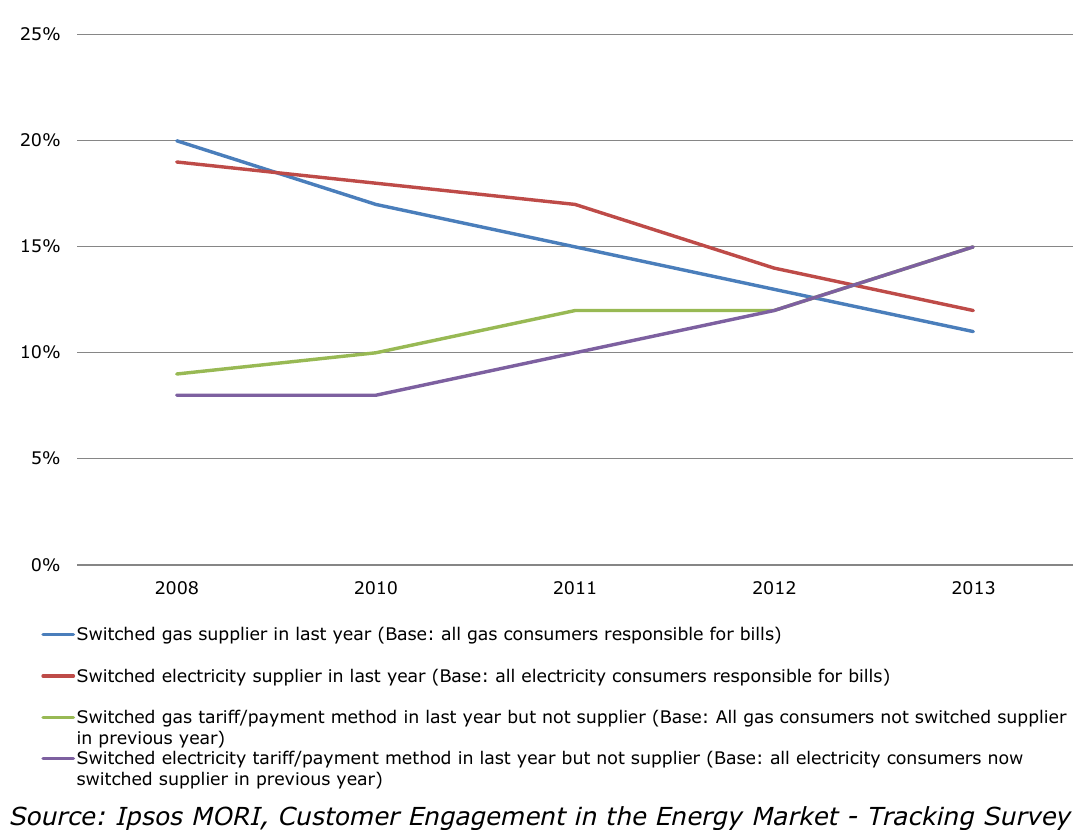
Figure 10 Consumers who reported switching supplier, tariff or